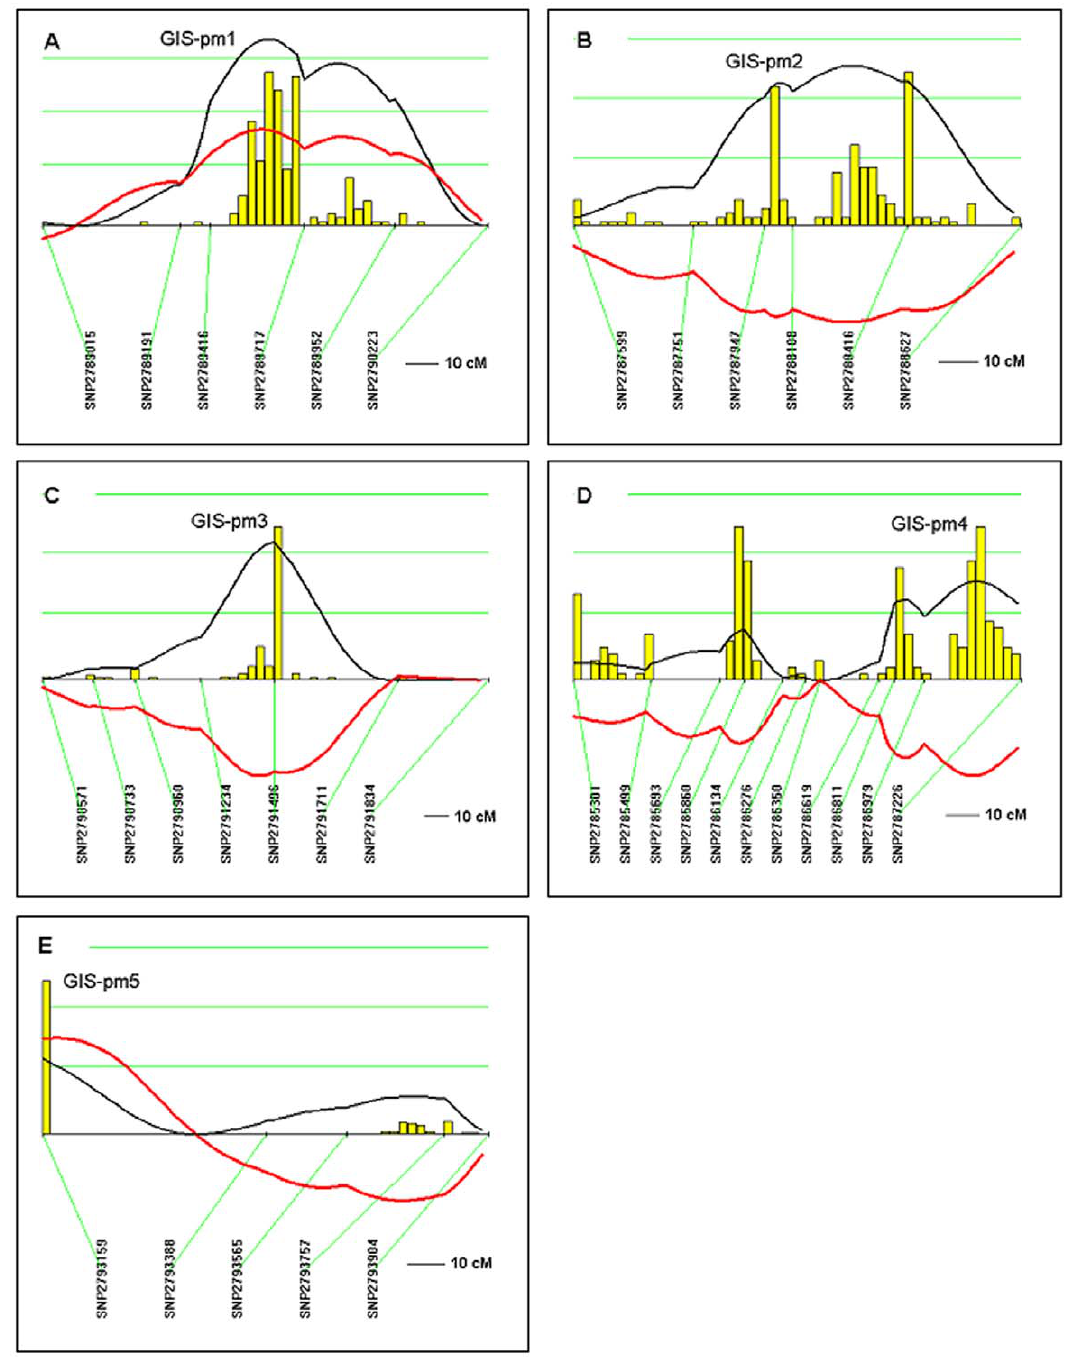
Figure 3. QTLs for glomerular injury score (GIS) in postmenopausal F2 (Dahl S x R)-intercross female rats. Chromosomes were analyzed by interval mapping with bootstrap resampling method to estimate a confidence interval (QTXb19 Map Manager): Panel A, chromosome 4 ( GIS-pm1 ); B, chromosome 3 ( GIS-pm2 ); C, chromosome 5 ( GIS-pm3 ); D, chromosome 2 ( GIS-pm4 ) and E, chromosome 7 ( GIS-pm5 ). Yellow histograms represent the bootstrap-based confidence intervals for the detected QTLs. Orientation of chromosomes: left R right starting from lowest Mbp. Horizontal green lines [—] mark LOD values for significance of linkage, from top to bottom: highly significant LOD $ 3.17; significant LOD $ 2.17; suggestive LOD $ 1.15; LOD [—]; regression coefficient [ — ]. doi:10.1371/journal.pone.0056096.g003 140.7 Mbp are possible candidates. Interestingly, Adcyap1r1 (also PACAP system has been associated with tubuloprotective effects in known as PAC1 receptor) and its ligand (PACAP) are present in the kidney [23–25]. Avp mapping to GIS-pm2 is a potential kidney, mainly on tubular epithelial cells [22]. The PAC1R/ candidate based on its well known relationship to chronic kidney